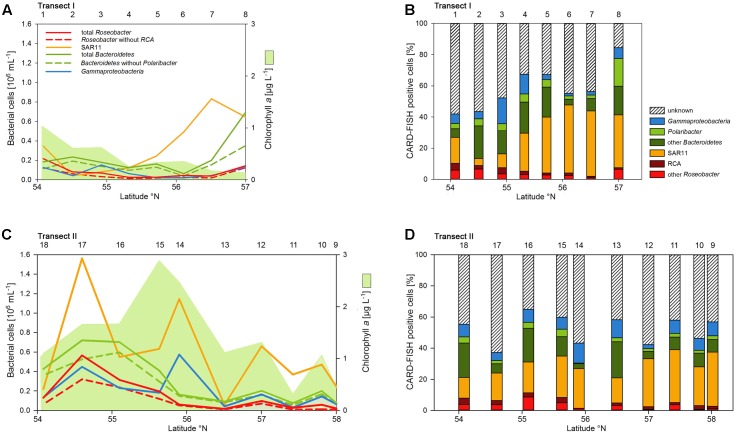
Cell numbers of the SAR11 clade, the Roseobacter group and its RCA cluster, Bacteroidetes and its Polaribacter cluster and of Gammaproteobacteria assessed by CARD-FISH and chlorophyll a concentrations measured spectrophotometrically of Transects I (upper panel) and II (lower panel) during early summer in the North Sea between 54° and 58°N. The red bars represent the Roseobacter group without the RCA cluster and the dark green bars Bacteroidetes without the Polaribacter cluster. The numbers above the panels indicate station numbers. (A,C) Show absolute cell numbers and chlorophyll a and (B,D) percentages of DAPI-stained cells detected by a group-specific CARD-FISH probe.